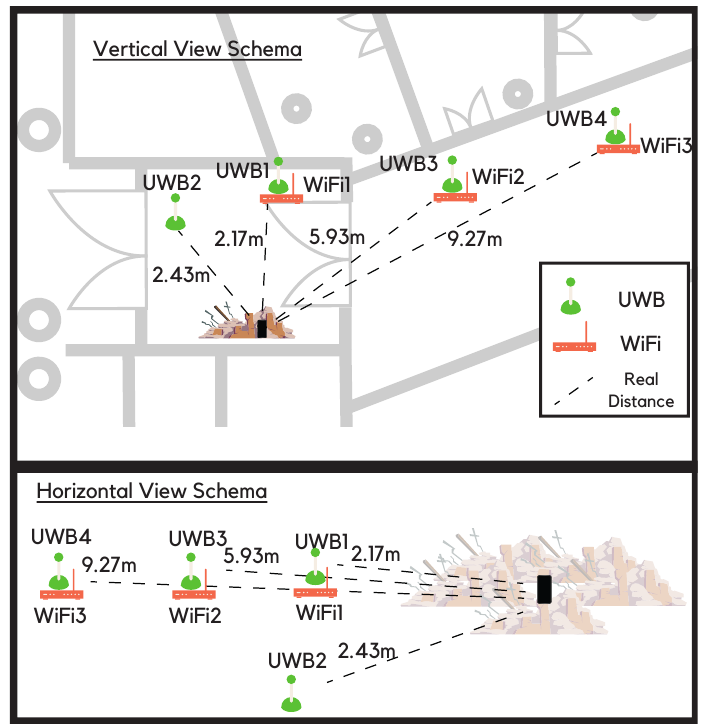
Figure 3. Schema of the position of the UWB and WiFi